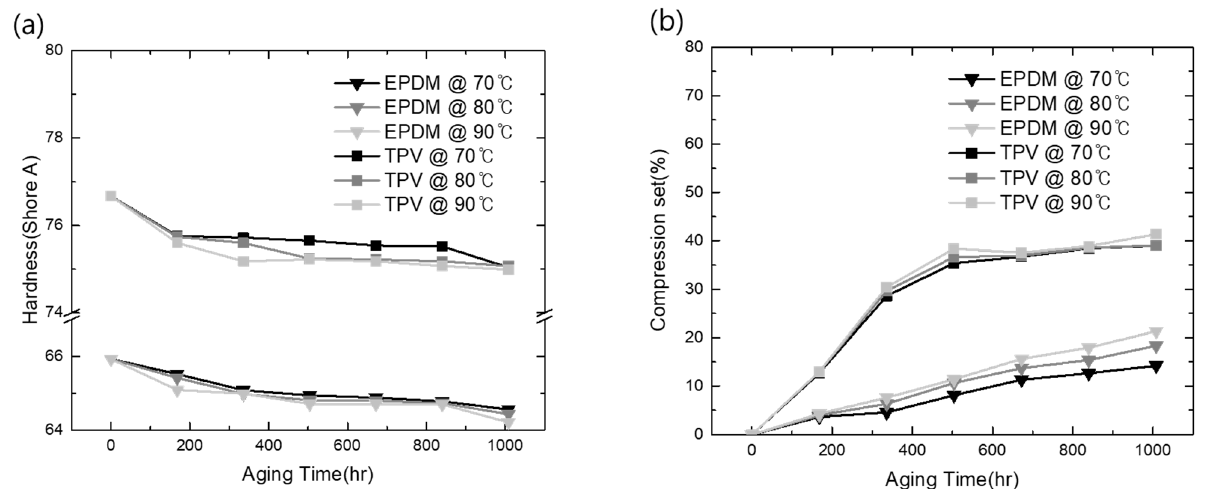
Figure 5. Mechanical property changes under acid conditions: ( a ) surface hardness changes; ( b ) CS changes.